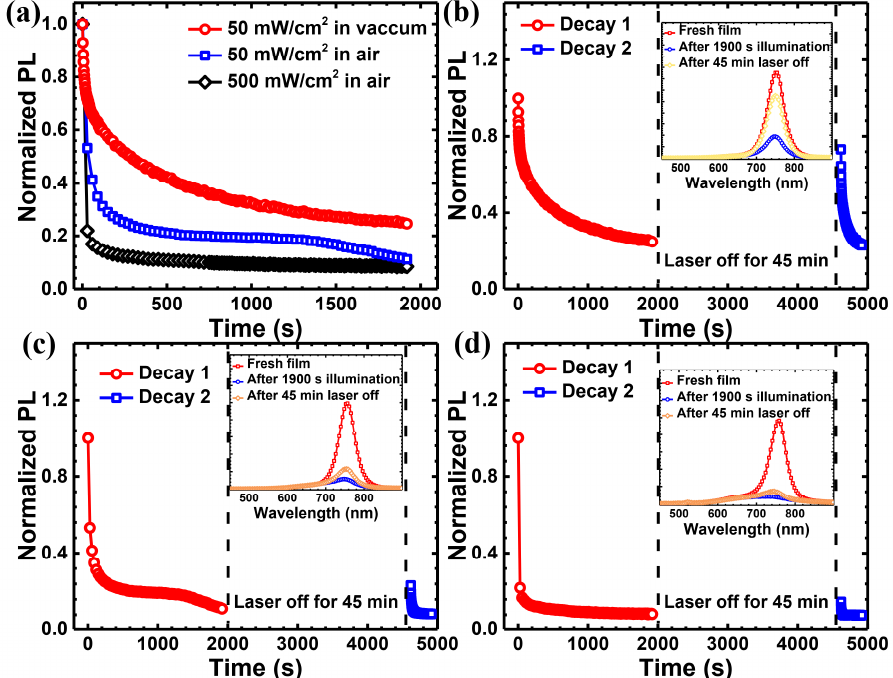
Figure 3. ( a ) Normalized time-dependent steady-state PL intensity of quasi-2D perovskites of PEA 2 MA 2 Pb 3 I 10 under continuous illumination using a 447-nm laser source under different condi- tions. ( b ) The PL intensities over time of PEA 2 MA 2 Pb 3 I 10 under laser excitations at 50 mW/cm 2 in a vacuum, ( c ) the laser excitations at 50 mW/cm 2 in an ambient environment, ( d ) the laser excitations at 500 mW/cm 2 in an ambient environment. The respective illumination stops at 1900 s for a dark treatment of 45 min before resumption. The corresponding PL spectra of the PEA 2 MA 2 Pb 3 I 10 film at various time points are shown in the inset of the respective figure panel.